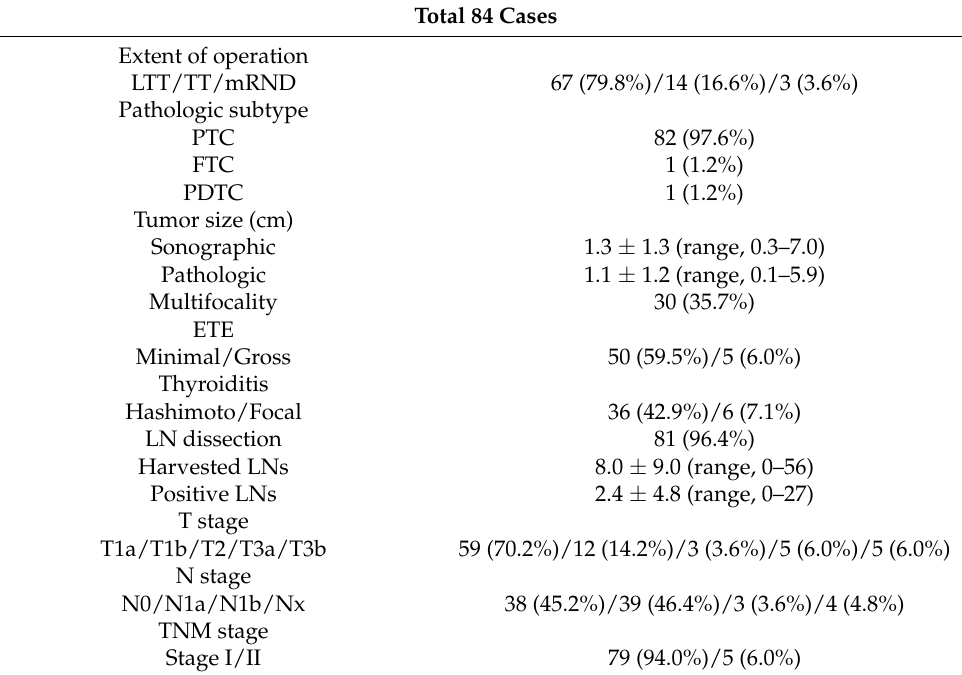
Table 3. Clinicopathological characteristics of the patients with